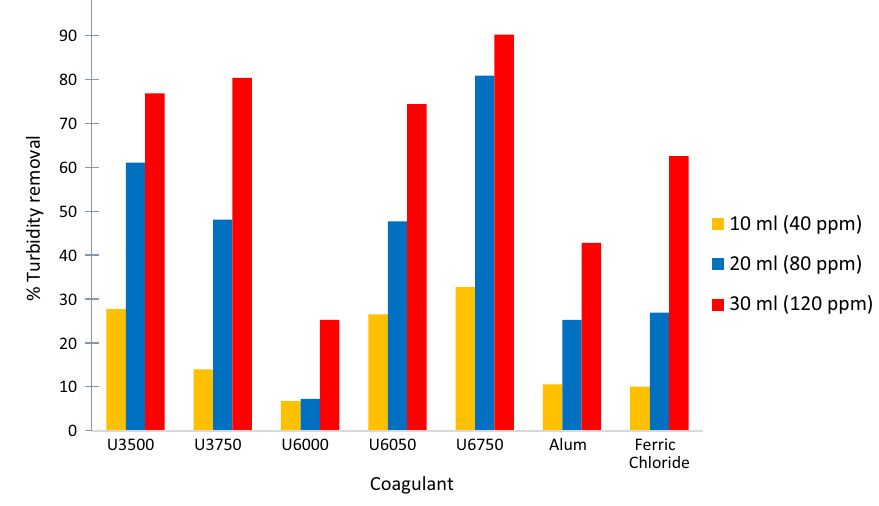
Fig. 2 Preliminary coagulation